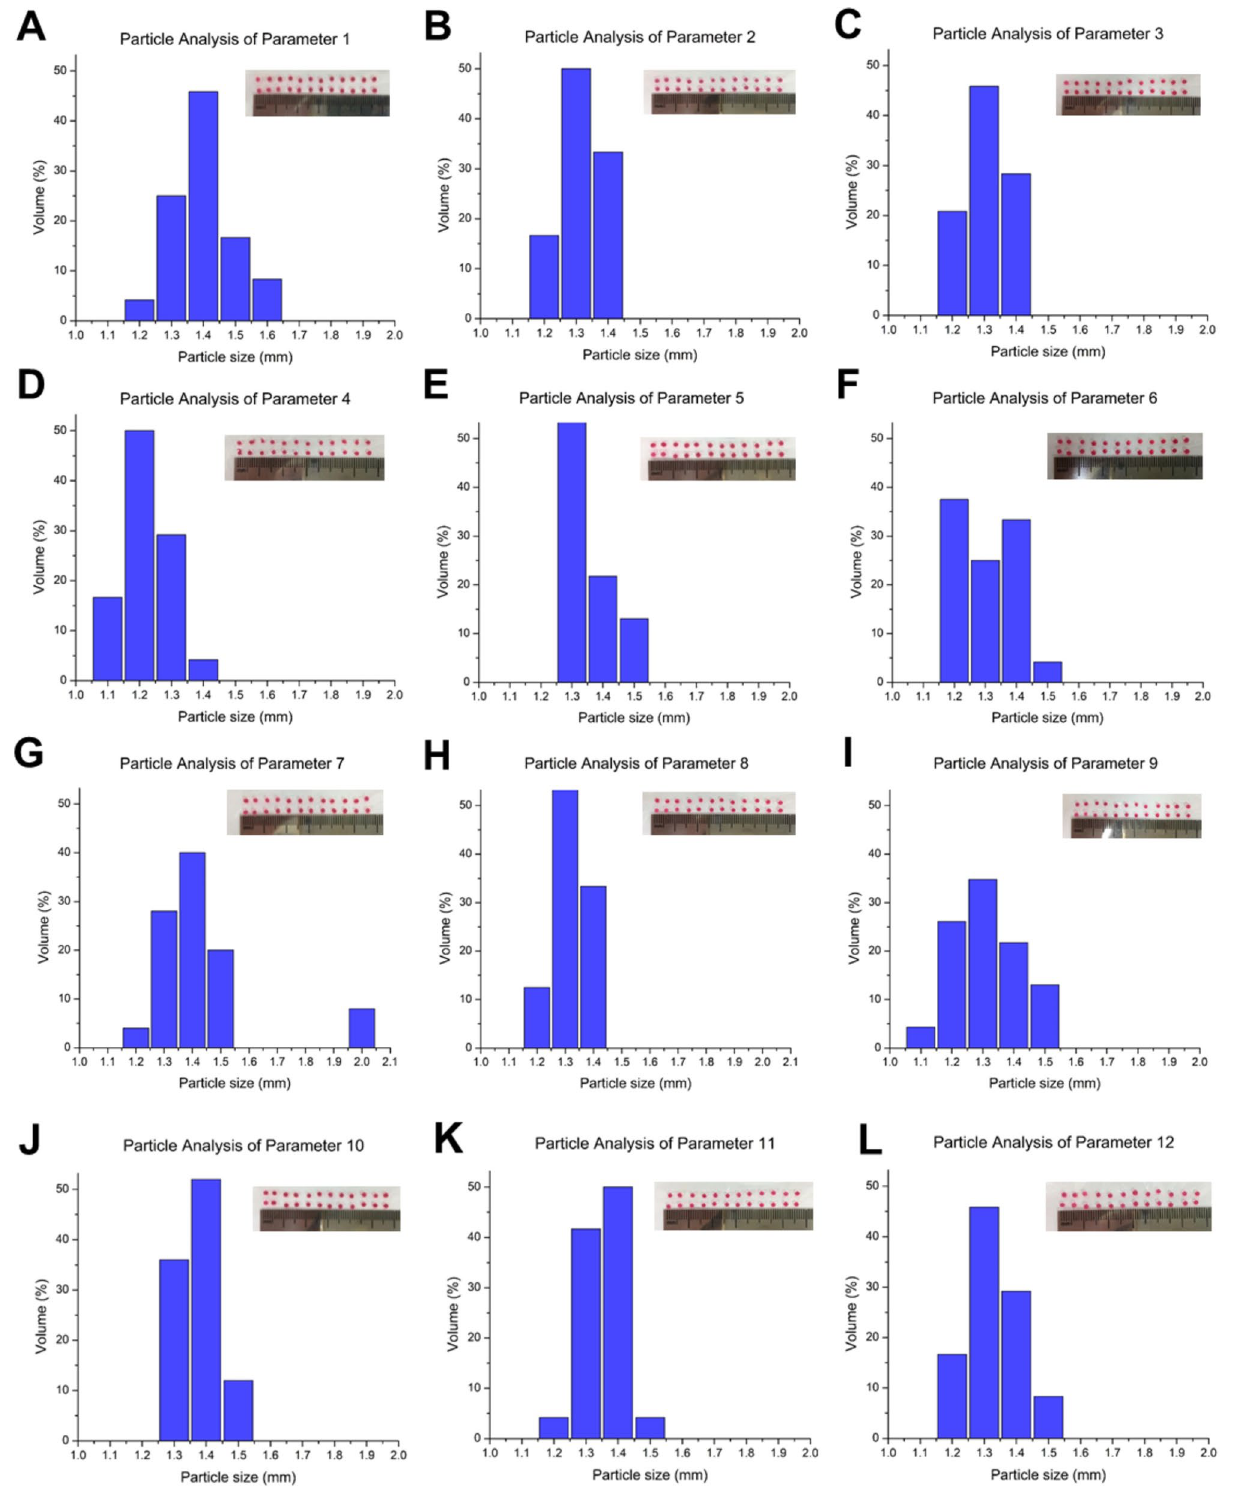
Figure 1. ( A – R ) The distributions of diameter (mm) and volume (%), and appearances of calcium alginate microcarriers with 18 different parameter